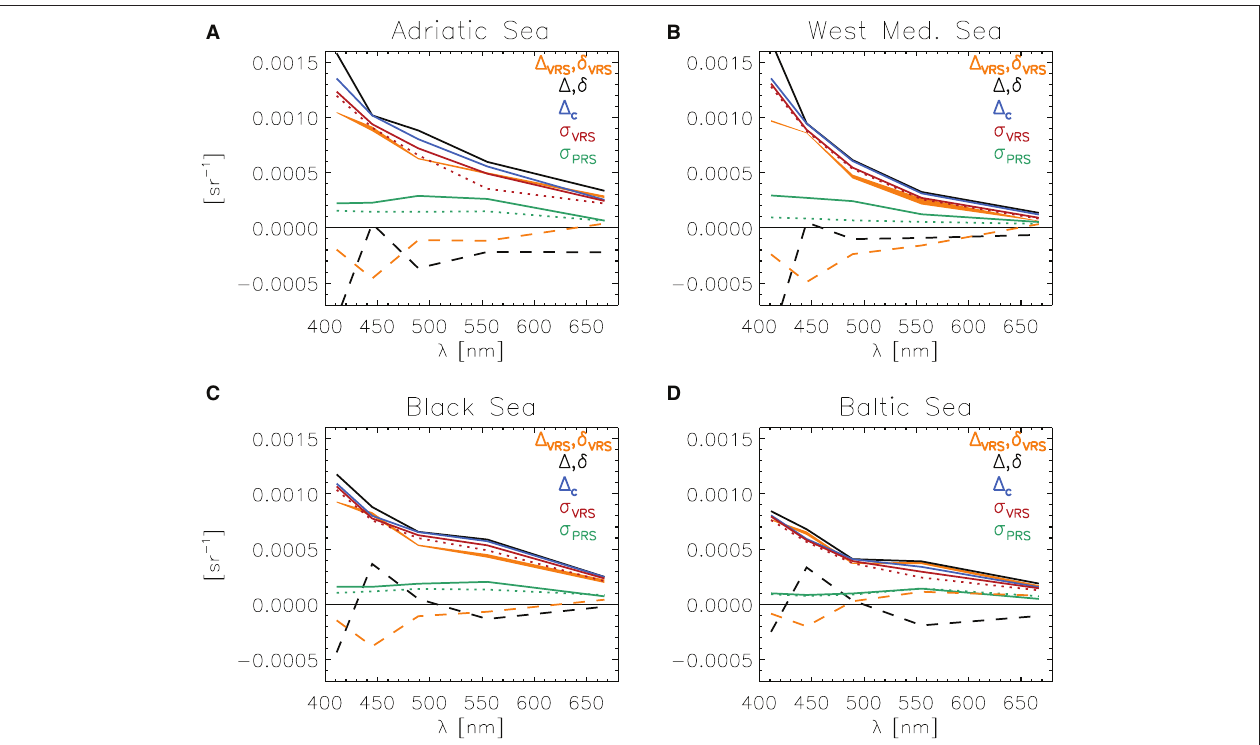
FIGURE 6 | Spectra of statistical quantities for VIIRS-JPSS1 for sites in (A) the Adriatic Sea, (B) the Western Mediterranean Sea, (C) the Black Sea, and (D) the Baltic Sea. Comparing JPSS1 and PRS field data: 1 is the RMS difference (solid line), δ is the average difference (dashed line) and 1 c is the centered RMS difference. Comparing VIIRS SNPP and JPSS1 data, 1 PRS is the RMS difference (sold line), δ VRS is the average difference (dashed line, JPSS1-SNPP). σ PRS is the uncertainty associated with PRS field data (solid green line); the average standard deviation of the measurements used for each match-up is shown with a dotted green line. σ VRS is the JPSS1 uncertainty term associated with random effects, without and with correction for representation error (solid and dotted lines, respectively). Note that 1 VRS and δ VRS are equally represented in Figure 5 .